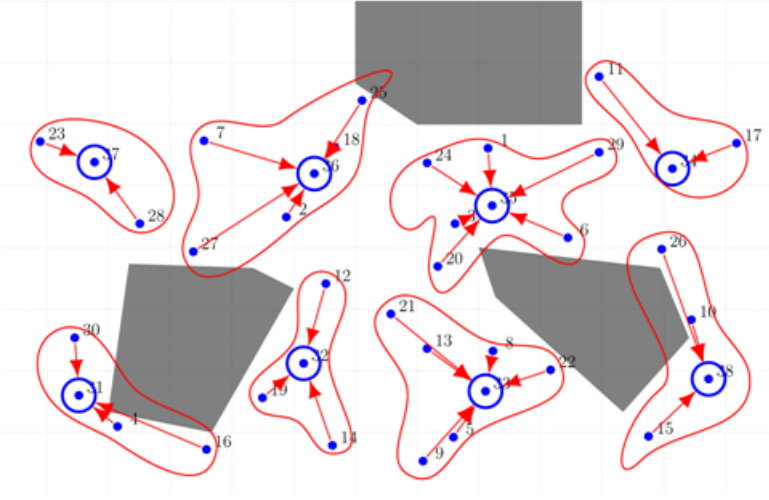
Figure 11. Clustered WSN—Simulation result (normal and head sensors with cluster highlighting).